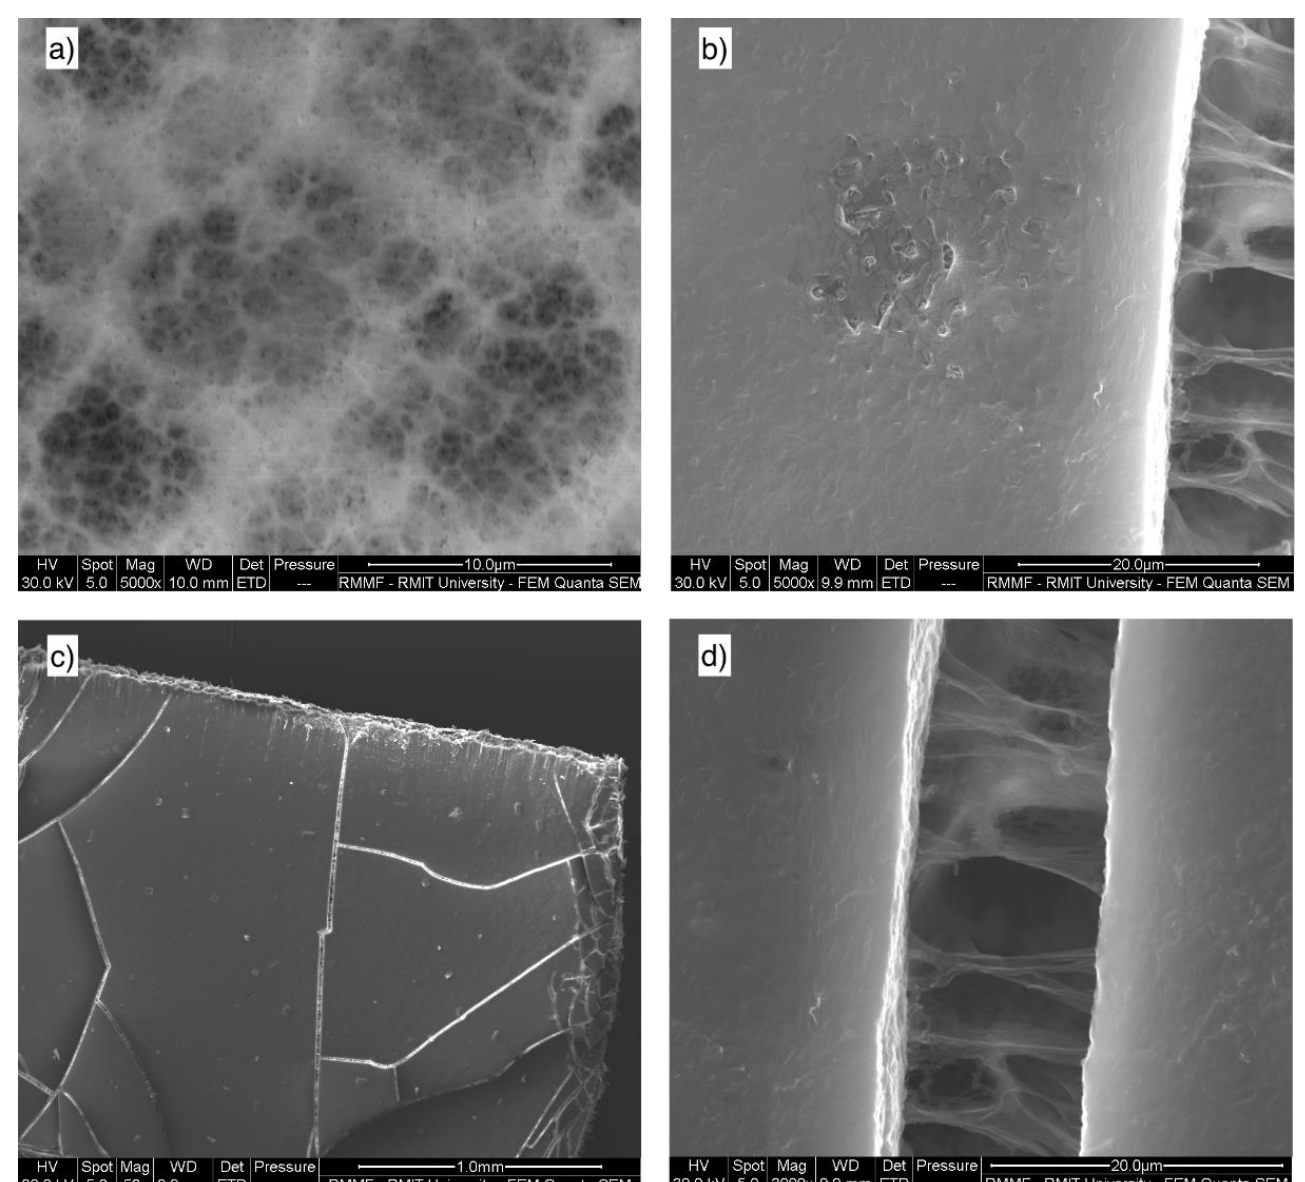
Figure 7. Scanning electron microscopy (SEM) of images of PVDF flat-sheet membrane. ( a ) Pristine membrane (5000×), ( b ) membrane used in TSWW treatment (5000×), ( c ) membrane used in TSWW treatment (50×), and ( d ) membrane used in TSWW treatment (3000× of magnitude).